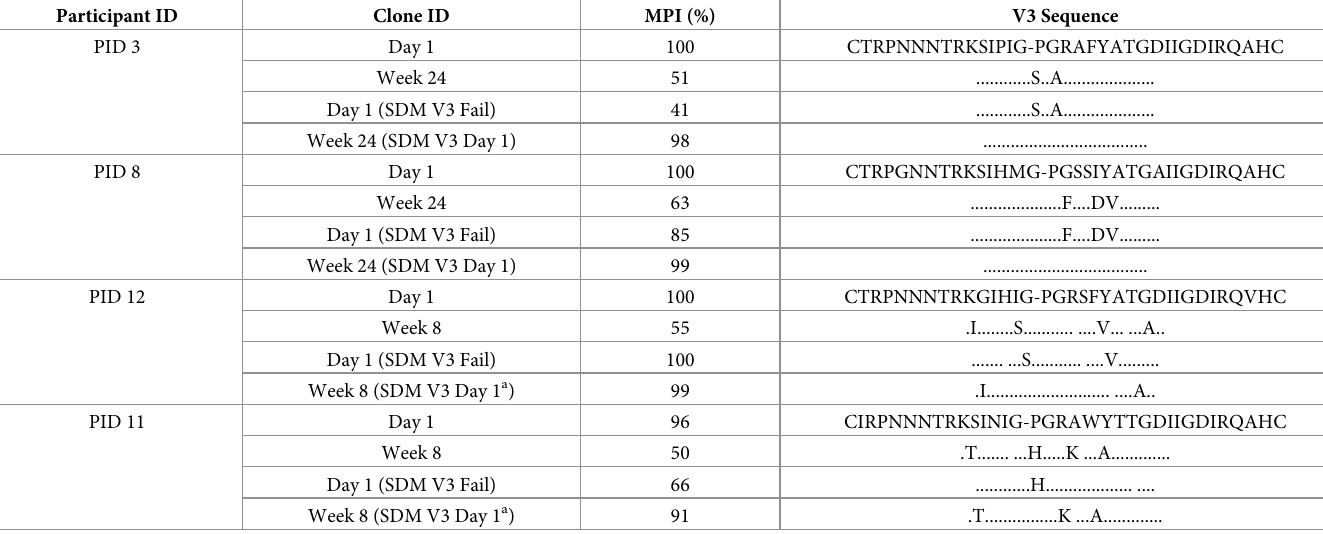
V3 Sequence gp120 V3-loop sequence position in HXB2 (NCBI accession number K03455) env is 296 to 331. Dots indicate residues identical to the Day 1 maraviroc- sensitive envs and dashes indicate gaps. a